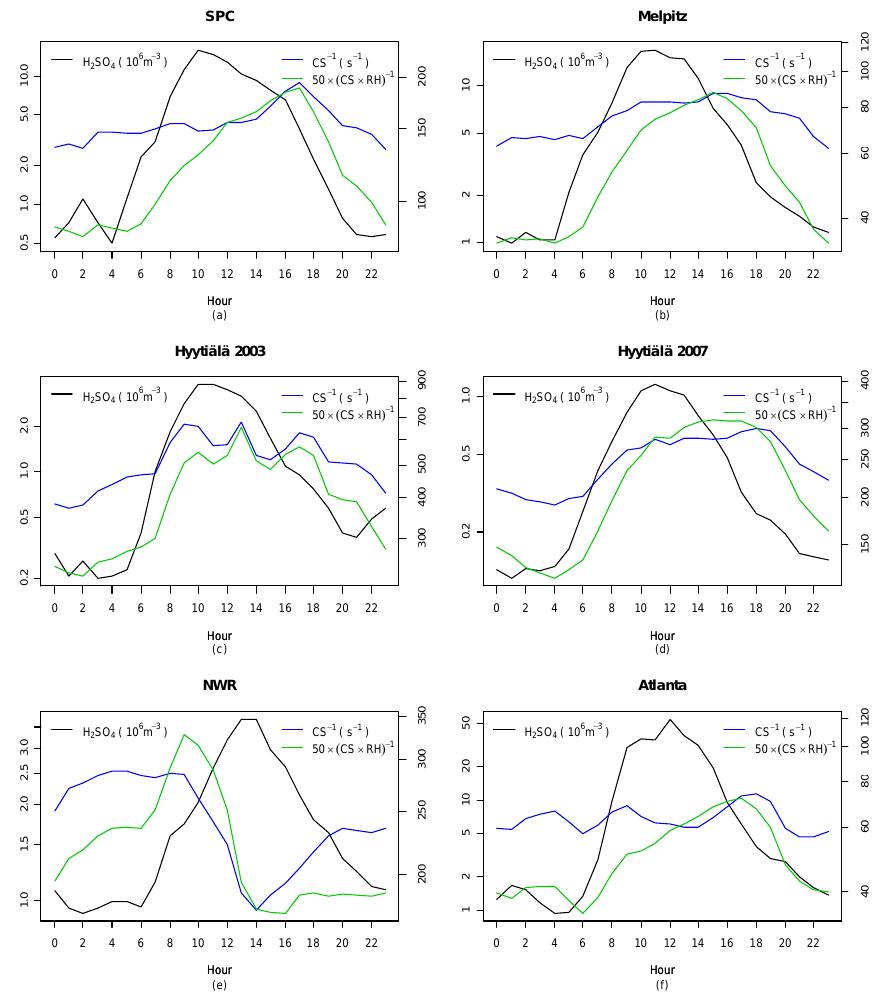
Fig. 4. Average daily fluctuations of sulphuric acid (left axis), inverse condensation sink and inverse condensation sink multiplied by relative humidity (right